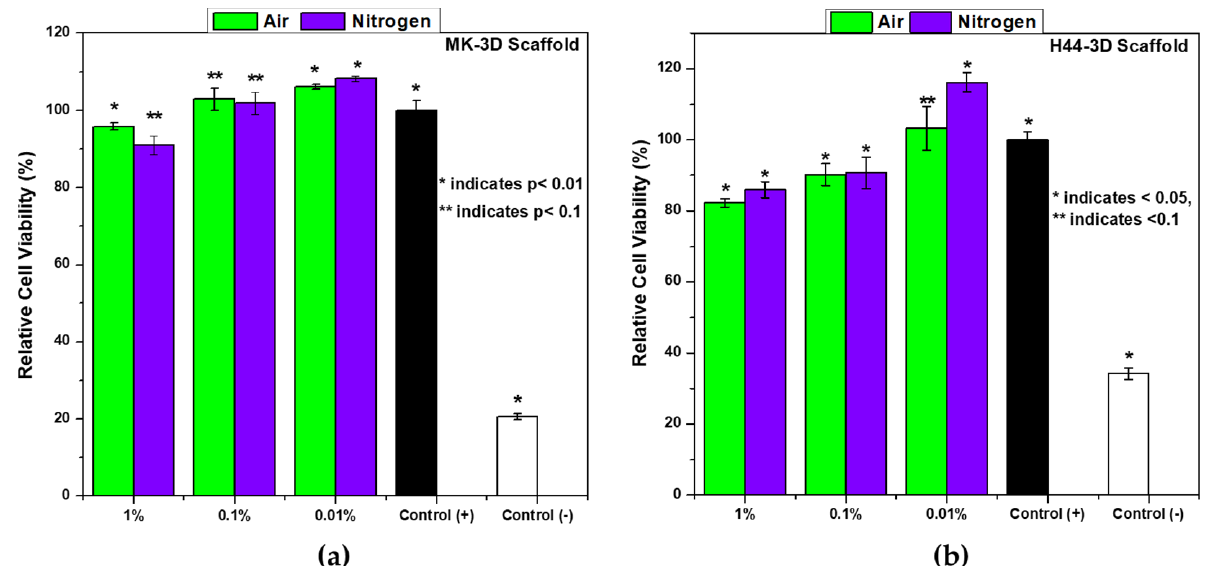
Figure 7. Cell viability of ST-2 cells treated with the supernatant of different concentrations (0.01–1 wt/vol.%) of MK ( a ) and H44-based ( b ) Biosilicate ® -like 3D scaffolds after 48 h of incubation.